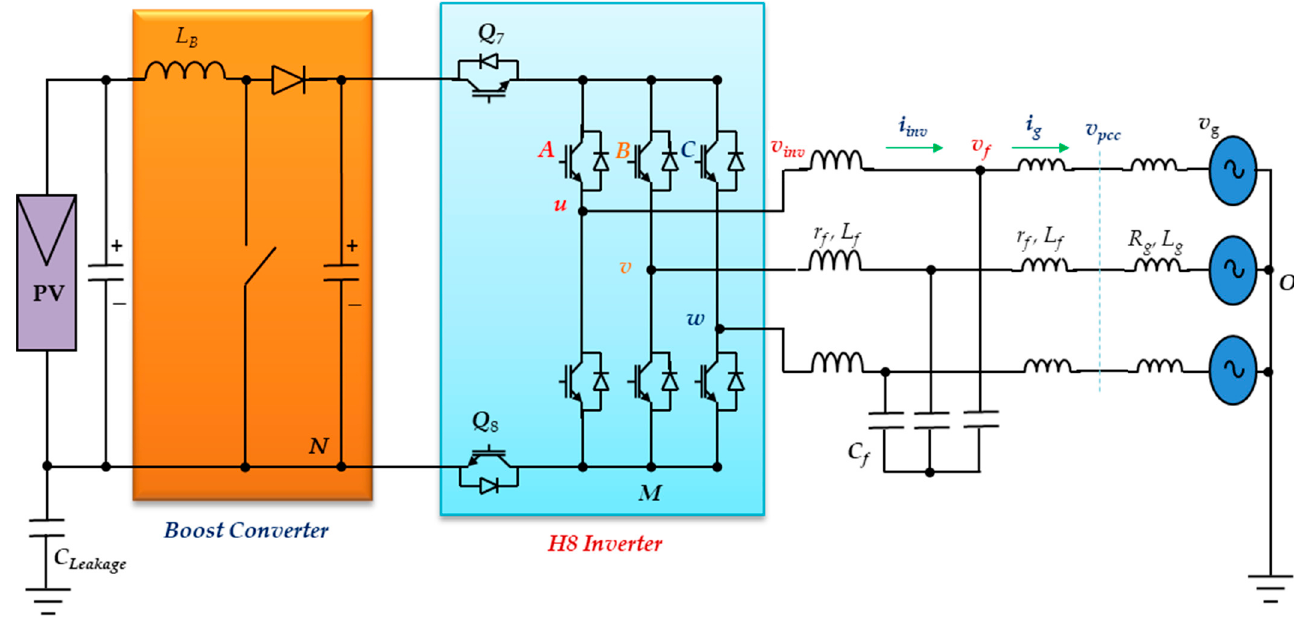
Figure 1. The power circuit of the proposed system. The configurations of the H8 transformerless inverter for different switching states of the inverter are shown in Figure 2.